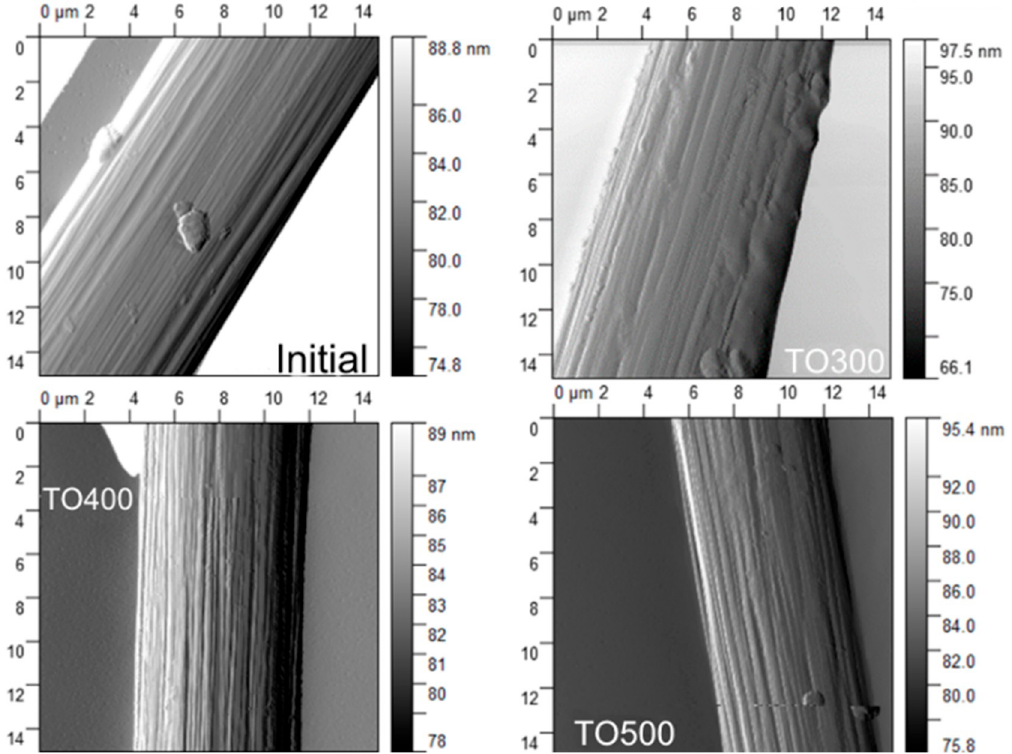
Figure 9. AFM photos of carbon fibers before and after surface modification.